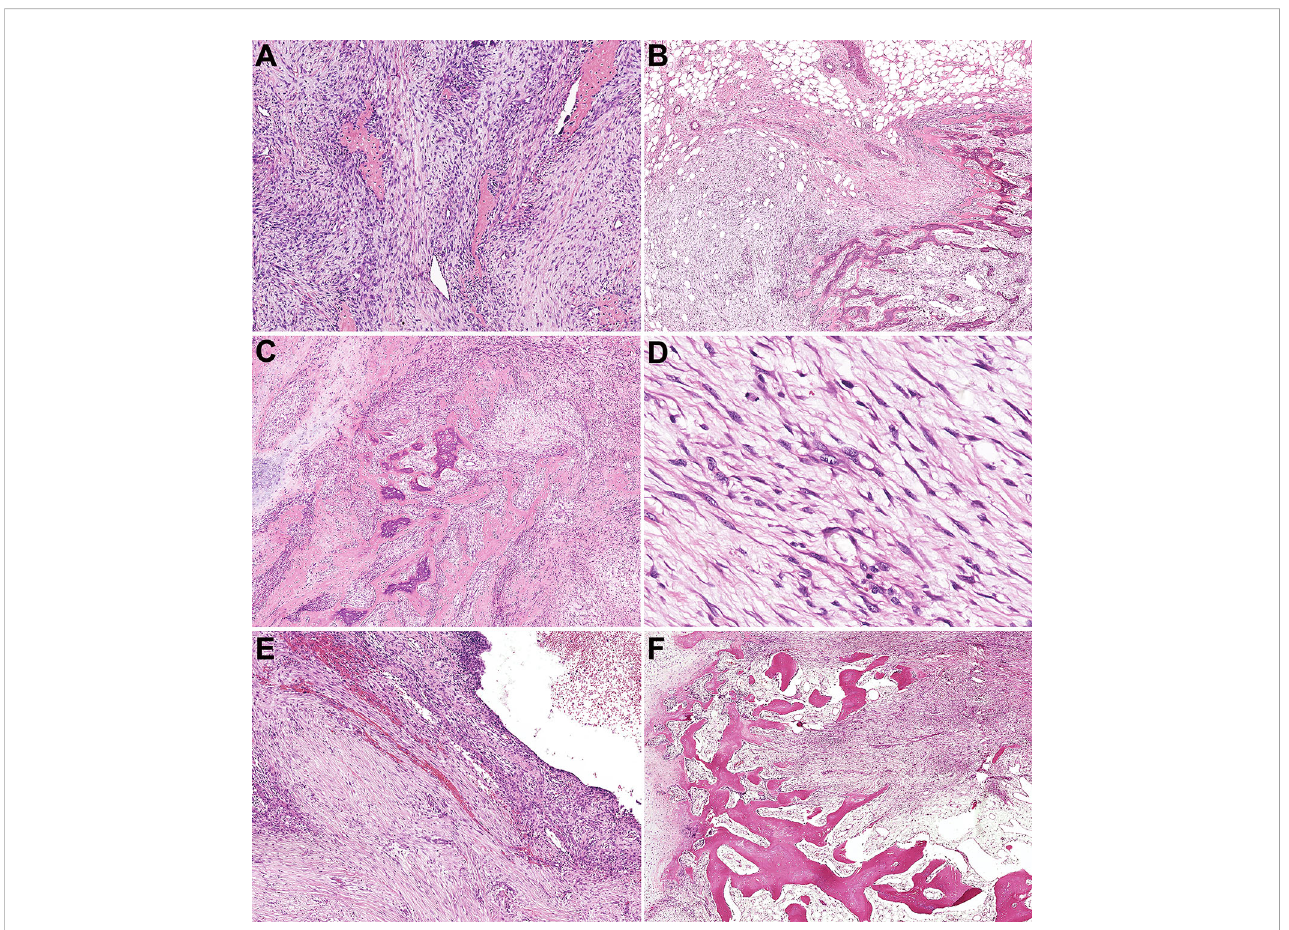
FIGURE 3 Histopathologic characteristics of fasciitis ossi fi cans and soft tissue aneurysmal bone cyst. (A) Osteoid tissues were distributed disorderly in an NF-like background in fasciitis ossi fi cans (Case 66). (B) In one fasciitis ossi fi cans case, the tumor was locally invasive with a reverse zonation structure. (Case 63). (C) Myo fi broblasts/ fi broblasts cells were hyperplasia with mild atypia, and immature osteoid tissue was scattered among them. (Case 63). (D) Mitotic fi gures with no atypia were presented in myo fi broblasts/ fi broblasts (Case 63). (E) Soft tissue aneurysmal bone cyst showed a cystic cavity with hyperplastic myo fi broblasts/ fi broblasts and focal osteoid tissue in the cystic septum (Case 60). (F) In one soft tissue aneurysmal bone case, MO-like zone structure was observed and bone shell was formed around the tumor (Case